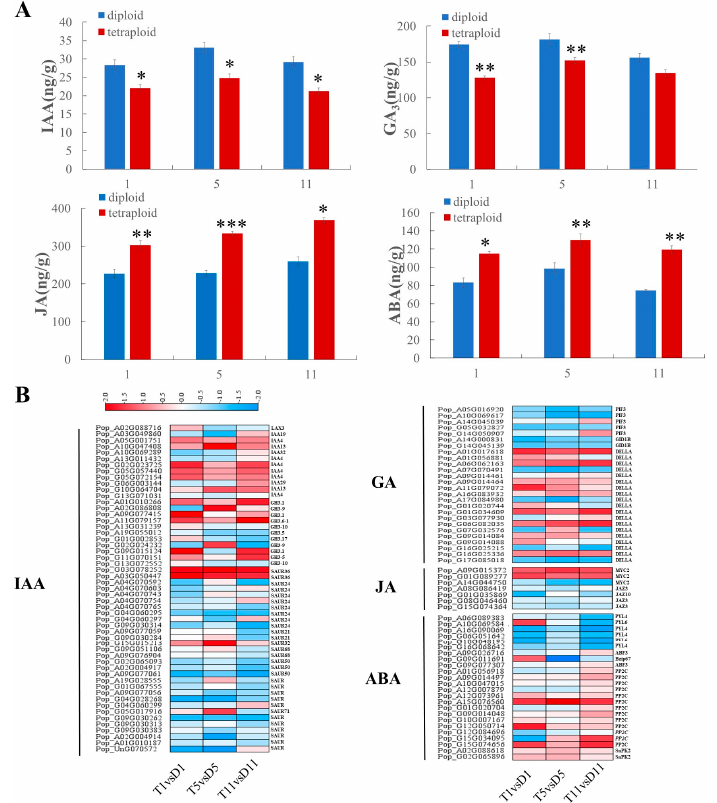
Figure 4. Differentially expressed genes (DEGs) of transcription-level hormone pathways leading to changes in hormone contents in tetraploid poplar 84K. ( A ) Comparison of endogenous hormone contents in leaves at three nodes of diploids and tetraploids; * p < 0.05, ** p < 0.01, *** p < 0.001. ( B ) DEGs associated with auxin (IAA), gibberellin (GA), abscisic acid (ABA), and jasmonic acid (JA) in tetraploids and heatmap of the log 2 fold change. Red and blue colors indicate up- and downregulation, respectively.